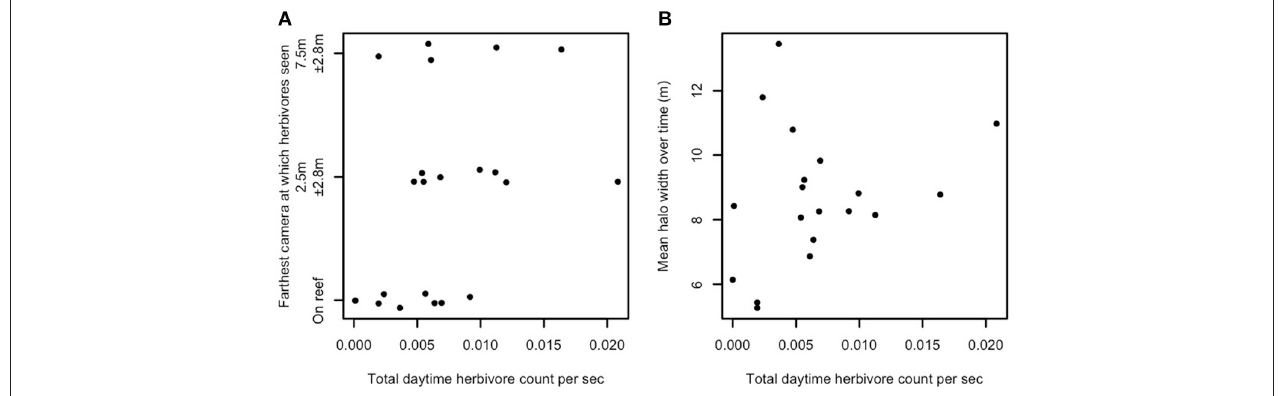
FIGURE 2 | Relationship between herbivore abundance, behavior, and halo width. Herbivore abundance per unit time against (A) field of view (FOV) of farthest camera visited by herbivores (vertically jittered for better visibility) and (B) time-averaged halo width, in Heron lagoon. Twenty-one patch reefs are shown in (A) , as no herbivores were seen on one patch reef which had video cameras. Nineteen patch reefs are shown in (B) , as no halos were measured around three patch reefs which had video cameras. Y-axis values in (A) represent the range of horizontal distance along the benthos from the edge of each patch reef that was within each camera’s FOV. Herbivores in this plot include all species observed feeding in any of the halos (i.e., Acanthurus spp., Siganus spp., Zebrasoma veliferum , and Naso unicornis ). Abundances are extrapolated to estimate total abundance at each reef.